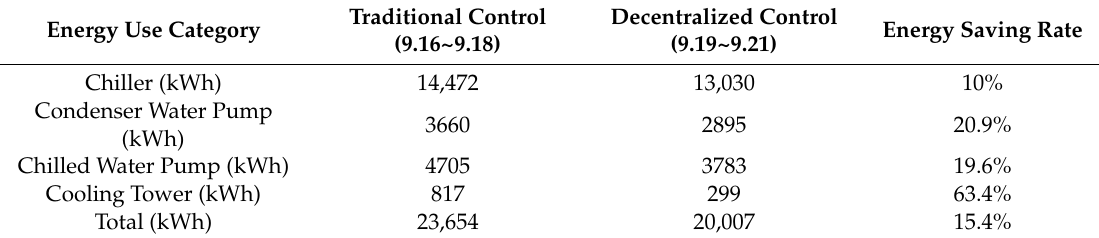
Figure 10. Comparison of the energy use of the main device. Table 6. Comparison of energy use under different control systems.